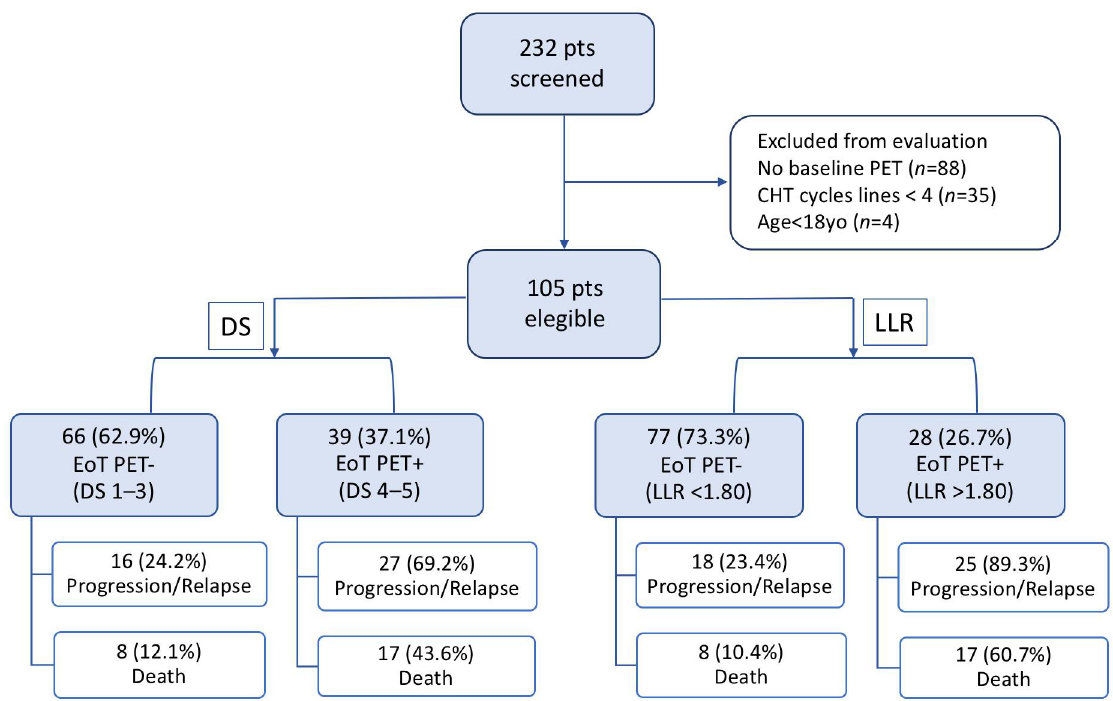
Figure 4. Flow chart of the selected patients’ outcomes screened either with Deauville Score (DS) or Lesion-to-Liver SUVmax ratio (LLR).